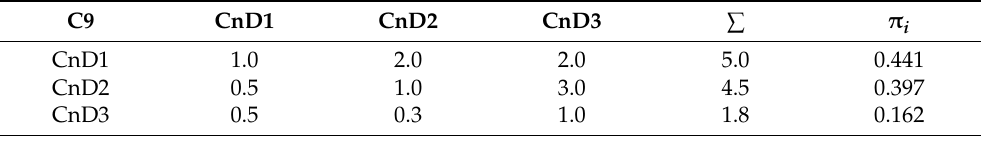
Table 13. Matrix of judgments.